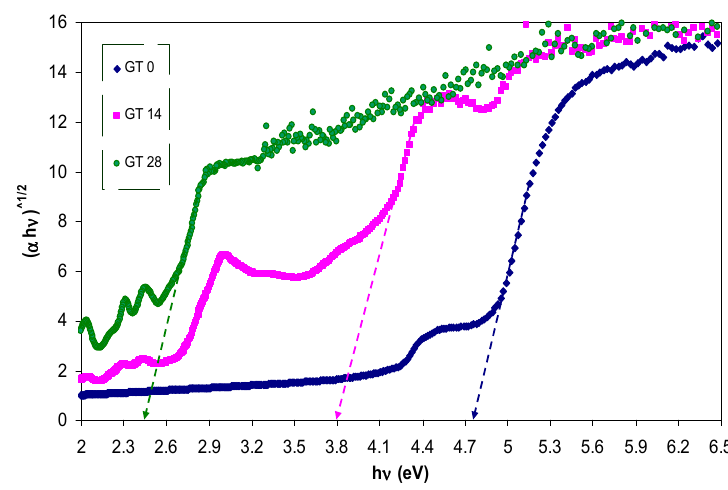
Figure 9. The plots of ( α h υ ) 1/2 vs. ( h υ ) for all the samples.